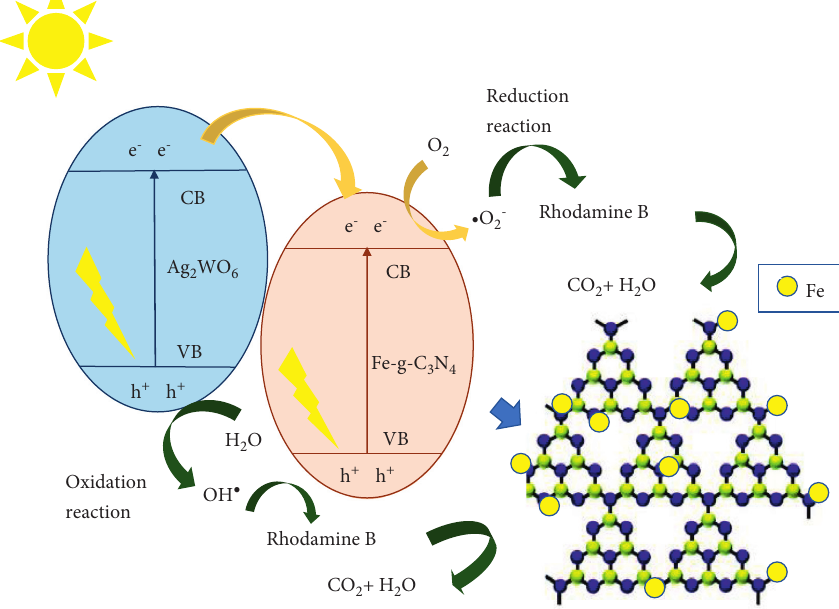
Figure 10: Proposed mechanism of rhodamine B dye degradation using ternary Fe-CN-AW.